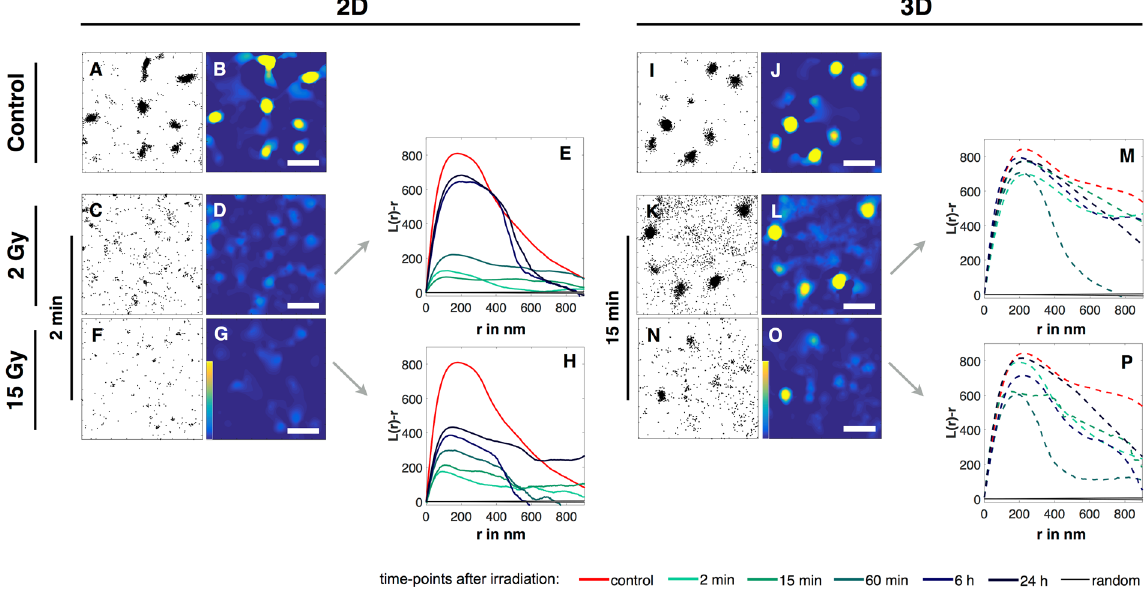
Figure 3. Effects of IR on the nanoscale distribution and organization of β 1 integrins of 2D and 3D cultured MEF cells. Single molecule localization data of integrin β 1 immunostainings obtained from fixed cells 2 min (2D) and 15 min (3D) after IR, as well as unirradiated controls are shown. Scatter plots show all detected β 1 integrin localizations ( A , C , F and I , K , N ), while the corresponding heat maps ( B , D , G and J , L , O ) visualize unclustered (dark blue) and clustered (yellow) regions; scale bas are 1 µ m. ( G , H and O , P ) Statistical analyses of all β 1 integrin localizations found in all recorded cells of a given culture condition and irradiation dose are shown as H-Plots of Ripley’s K function, in which the peak heights (L(r) − r) represent the degree of clustering and its position the most frequent cluster size (r (in nm)). Shown are the distributions of β 1 integrins as found for non irradiated, 2D cultured cells ( A , B ) for 2D cultured cells irradiated with 2 Gy ( C , D , E ), and for 2D cultured cells irradiated with 15 Gy, fixed 2 min after IR ( F , G , H ), respectively. The corresponding H-Plots ( E and H ) show results for control (red) and cells irradiated with 2 Gy fixed 2 min (turquoise), 15 min (light green), 1 h (green), 6 h (blue) and 24 h (dark blue) after IR. In addition, the analysis of a random distribution of localizations containing the same number of signals as the control is shown in black. ( I – P ) Corresponding data of 3D cultured cells, but fixed 15 min after IR. Heat maps of all remaining conditions (IR dose and time points after IR) are summarized in Figs S5 and